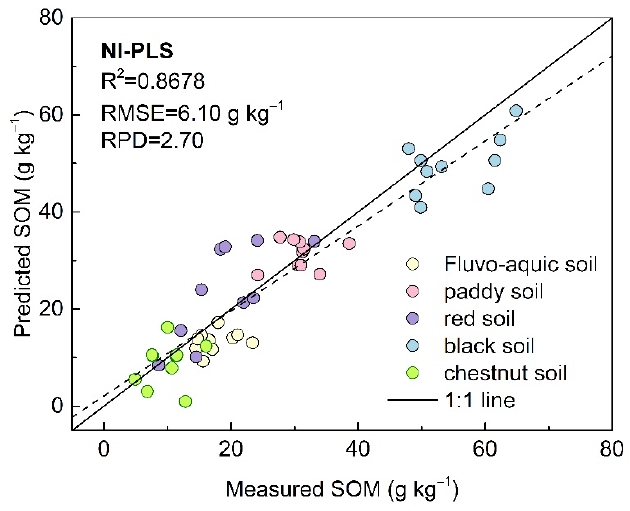
Figure 9. Scatterplot of prediction results and measured values obtained by SAM–PLSR at the national scale [22].